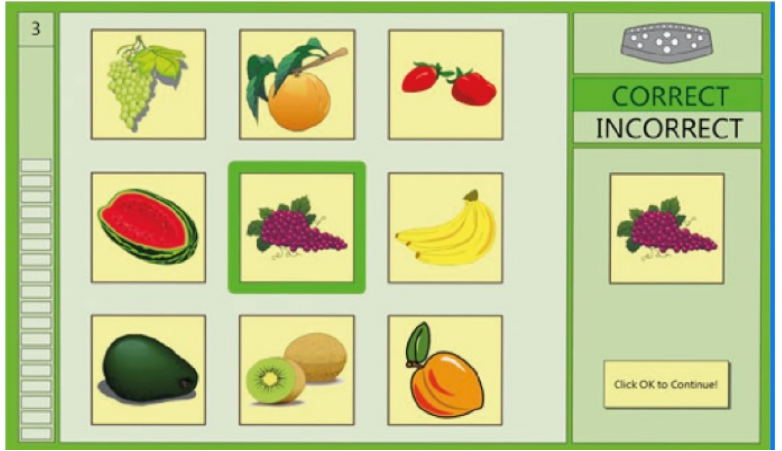
FigureA2. Example of attention. The software is available commercially in Greece, by Ostracon. For more